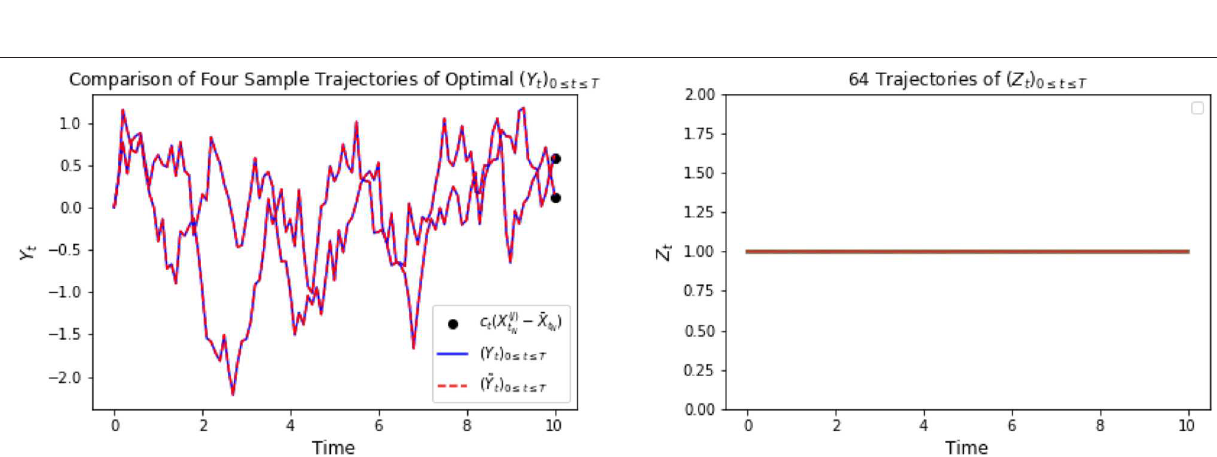
Frontiers in Applied Mathematics and Statistics |